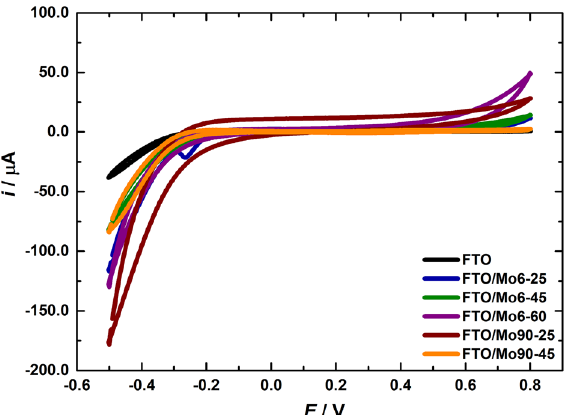
Figure 4. Cyclic voltammograms recorded for screen-printed FTO/MoS 2 electrodes, i . e . FTO/Mo6-25, FTO/ Mo6-45, FTO/Mo6-60, FTO/Mo90-25 and FTO/Mo90-45, respectively in a potential window of − 0.5 V–0.8 V